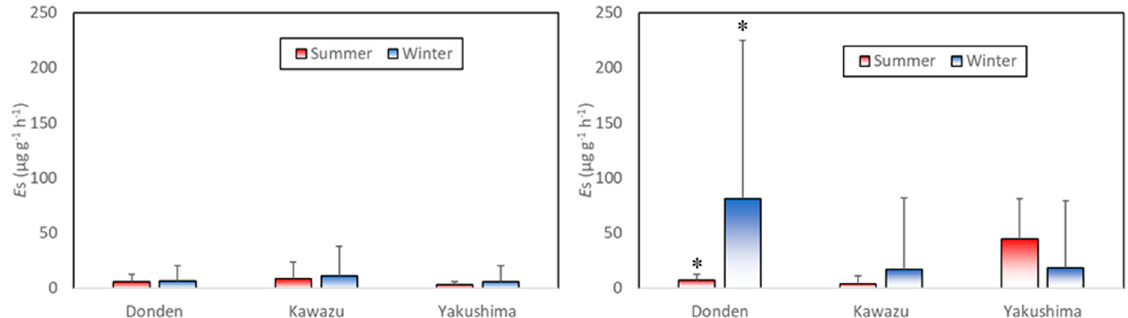
Figure 3. Comparison of the mean basal emission rate ( E s ) for the control ( left ) and ozone exposure ( right ) groups between the summer and winter. Error bars indicate the SD. Asterisk ( * ) indicates statistical di ff erences ( p < 0.05). The value of E s of Donden in the ozone exposure group in the winter was significantly higher than that in the summer ( p < 0.05).